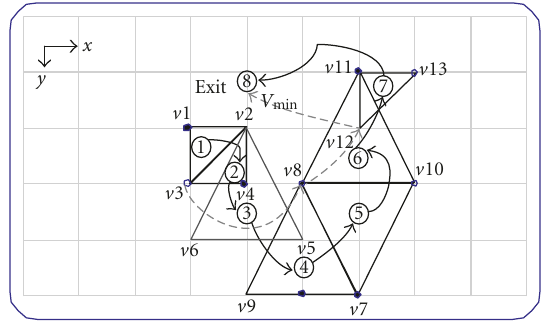
Figure 5: Example of a search pattern using FTS.